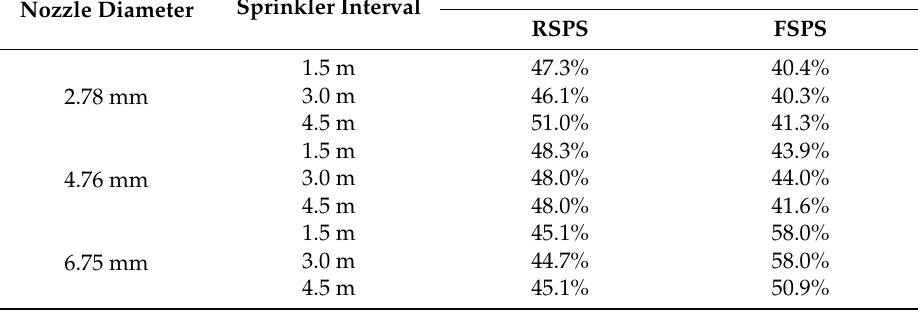
Table 6. Christiansen coefficients of uniformities ( CUCs ) of same-nozzle-sprinkler pipe sections (PSs) of rotating spray plate sprinklers (RSPSs) and fixed spray plate sprinklers (FSPSs) with differing nozzle diameters and sprinkler intervals.